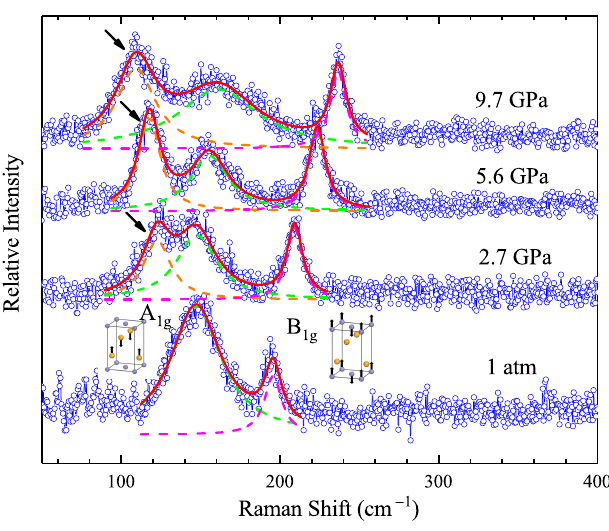
Figure 5. Peak splitting and fitting process of the pressure-dependent Raman scattering spectroscopy. The blue open symbols and red solid lines denote the experimental data and the fitting results, respectively. The green-, purple-, and yellow-dashed lines represent the peak fitting of the A 1 g , B 1 g , and the new phonon modes, respectively. The two inset pictures are the atomic-displacement patterns of Raman-active modes, the A 1 g and B 1 g modes, respectively. The blue atoms are the Fe atoms, while the yellow ones are the Se/Te atoms. The peak of the new phonon mode is marked by the black arrow. For clarity, four representative curves at different pressures were selected and displayed in this